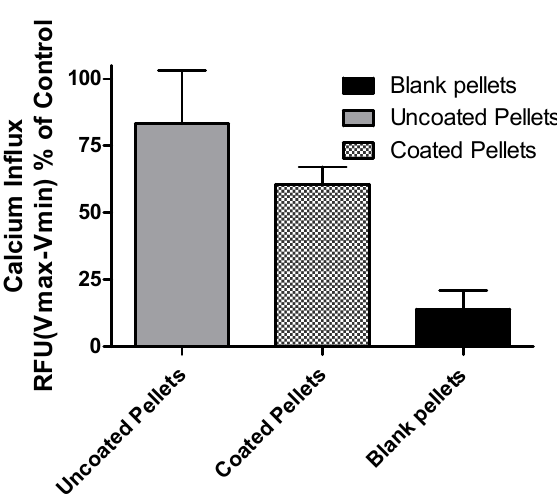
Figure 11. CasHyd retains bioactive functionality after encapsulation. Activity of CasHyd after encapsulation was determined relative to activity of non-encapsulated CasHyd in GHSR-1a- expressing cells. Activity was quantified as being 75% for uncoated pellets and 60% for coated pellets (representative of three independent experiments carried out in triplicate).